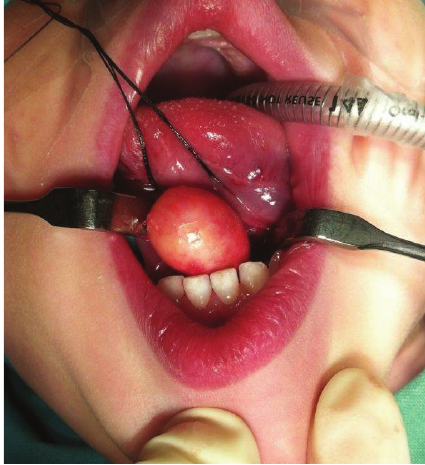
Figure 3: Surgical excision of the lesion.